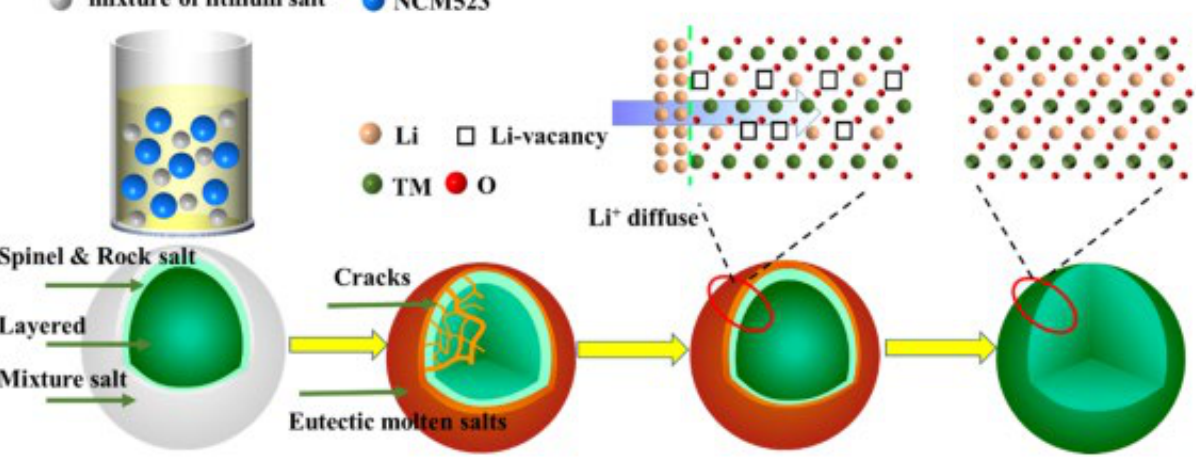
Figure 11. Schematic of the proposed re-lithiation process for lithium composition recovery by eutectic molten salts technique. Reprinted with permission from Ref. [82], Copyright 2020, American Chemical Society.